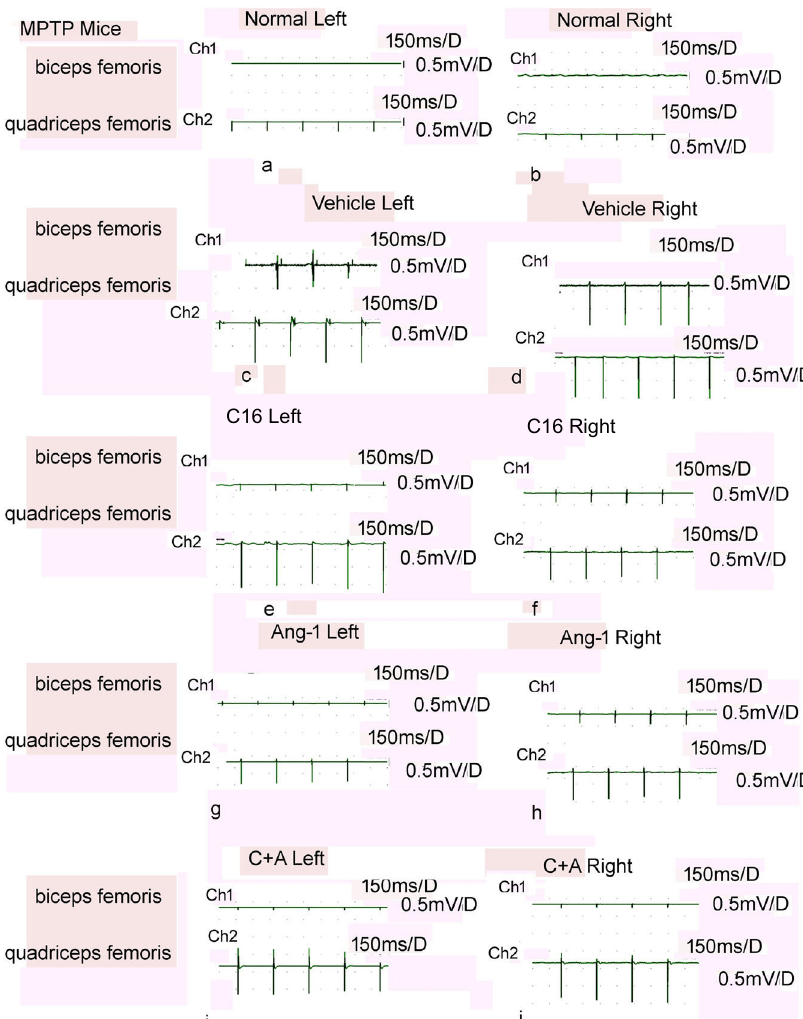
Fig. 2 C16 in combination with Ang-1 treatment alleviated the synchronous contraction of muscles. Compared with the normal control group ( a , b ), MPTP-injected mice showed synchronous contraction of agonist and antagonist muscles in both lower limbs, as measured by the wave amplitude (uV) ( c , d ). The antagonist muscle of the model animals treated with C16 alone ( e , f ), Ang-1 alone ( g , h ), and especially the combination of C16 and Ang-1 ( i , j ) did not contract with the agonist muscles synchronously after stimulation. MPTP, 1-methyl-4-phenyl- 1,2,3,6- tetrahydropyridine; C16, peptide (KAFDITYVRLKF) that can selectively bind integrin α ν β 3 ; Ang-1,